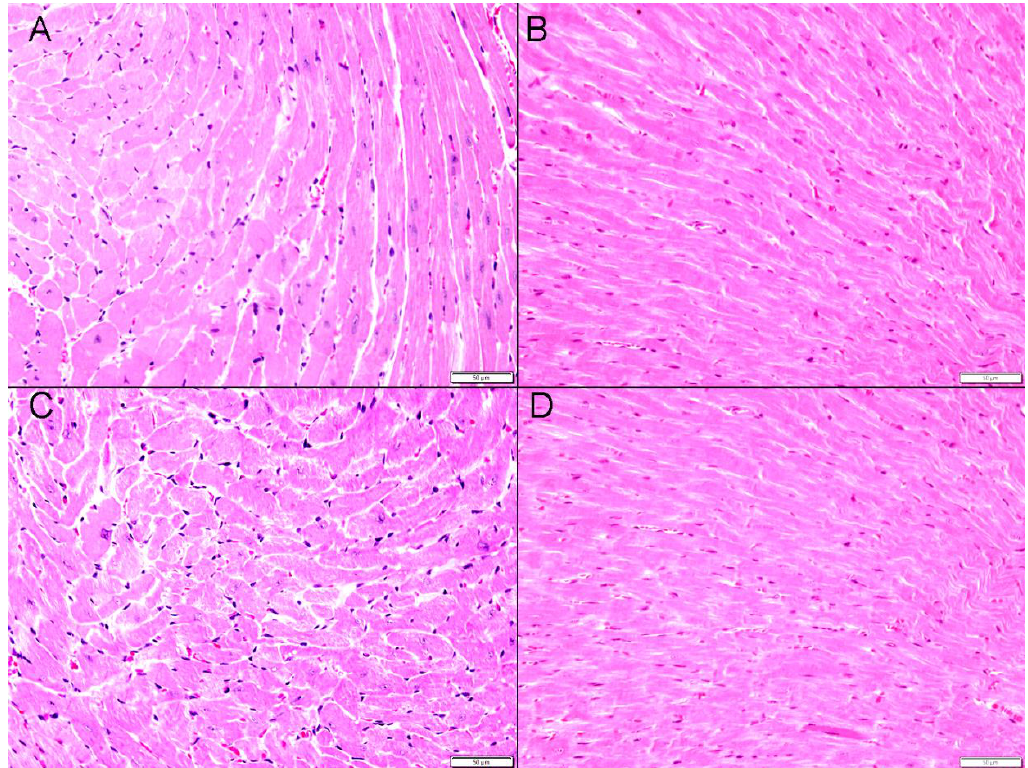
Figure 9. Effects of plain water-pipe smoke (P-WPS) or apple-flavoured (AF)-WPS on heart morphology. Representative light microscopy sections of hematoxylin and eosin stained heart tissues of mice at the end of 1 mo exposure period to either air ( A , B ) or P-WPS ( C ) or AF-WPS ( D ). ( A , B ) Representative heart sections obtained from air-exposed mice showing unremarkable heart morphology and architecture. ( C ) Representative heart sections obtained from P-WPS-exposed mice showing unremarkable heart morphology and architecture. ( D ) Representative heart sections obtained from AF-WPS-exposed mice showing unremarkable heart morphology and architecture. The scale bar equals 50 μm.